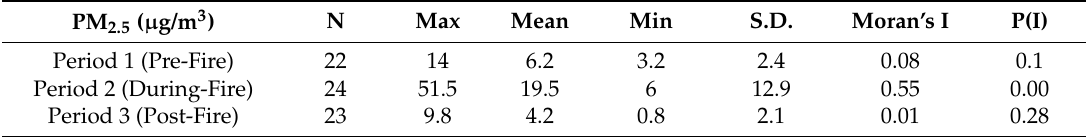
Table 2. Descriptive statistics of PM 2.5 concentration over three